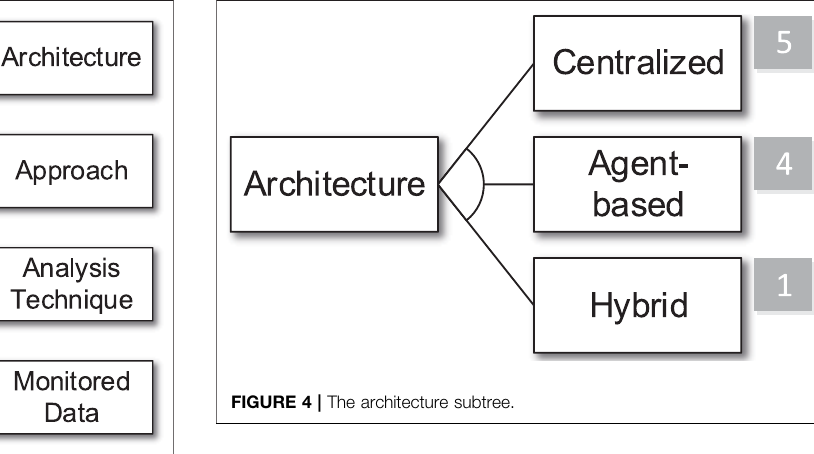
FIGURE 4 | The architecture subtree.